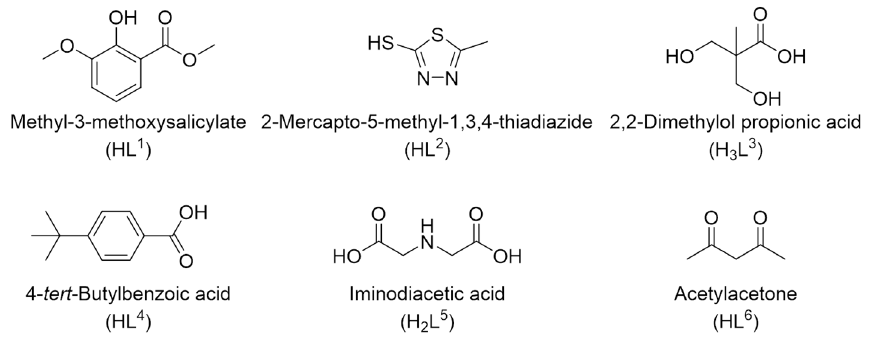
Figure 3. The structural formula and abbreviations of the hydrolysis-controlling ligands used in this review.